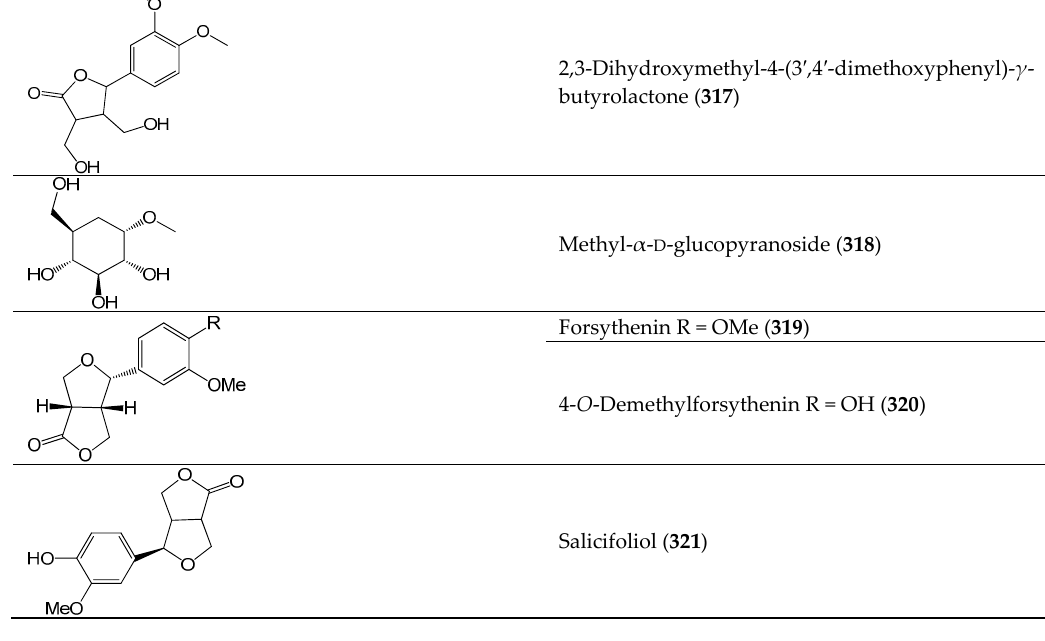
Figure 8. Chemical structures of other compounds in Forsythiae Fructus.